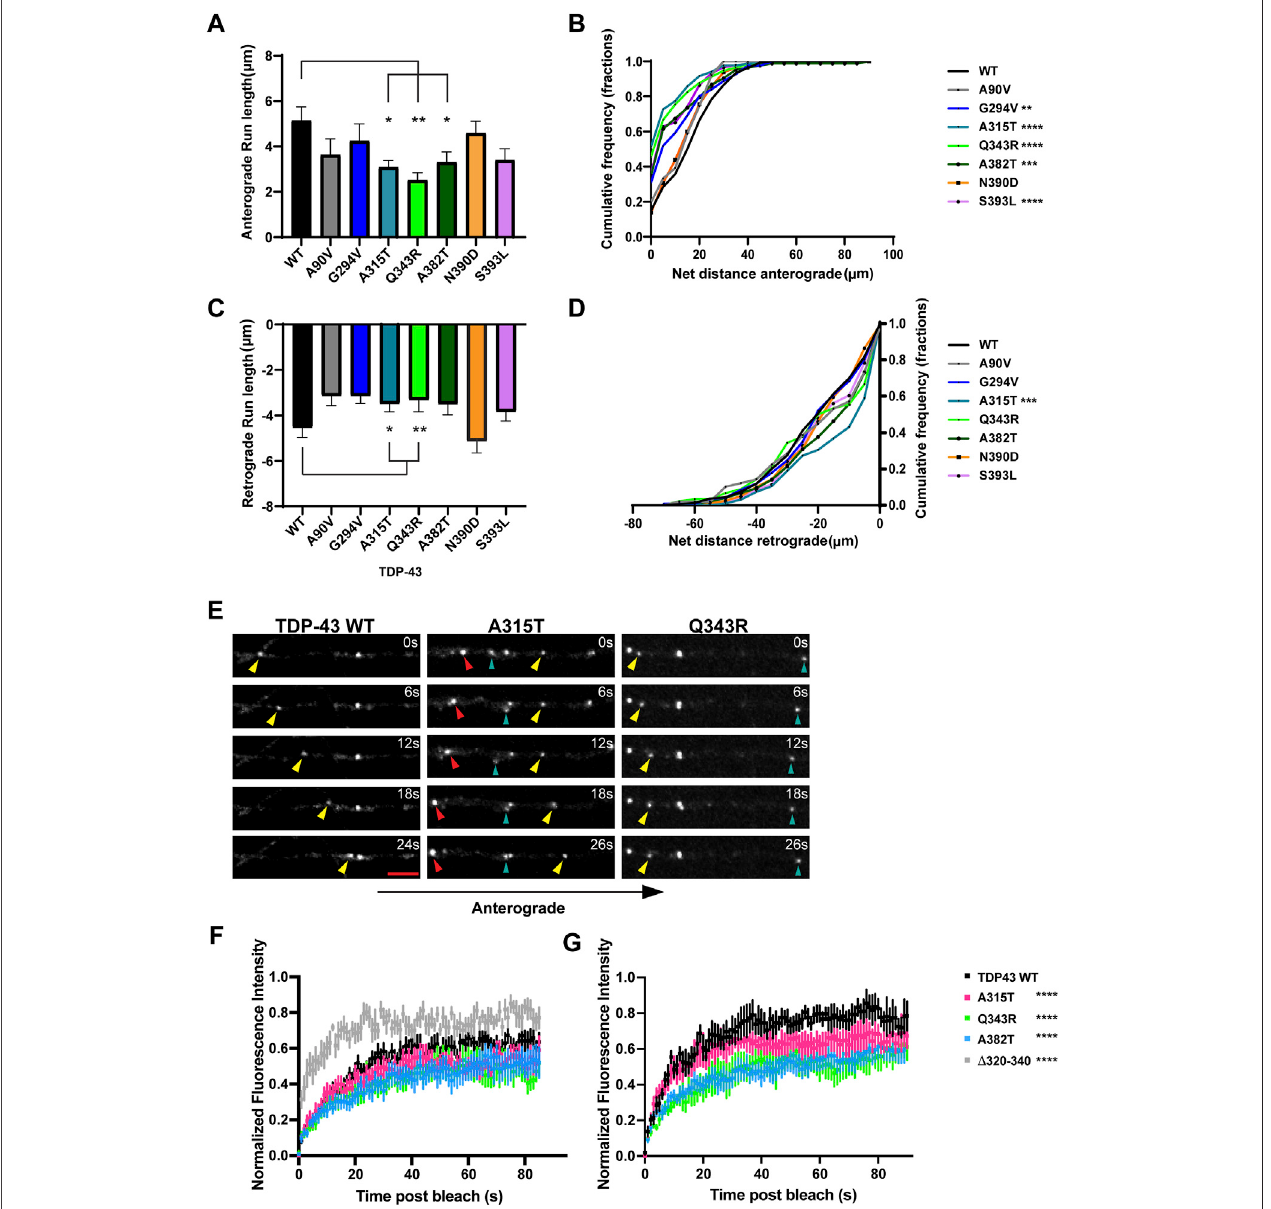
FIGURE 3 | ALS-linked TDP-43 mutants A315T and Q343R exhibit defects in anterograde and retrograde transport. (A) Anterograde run lengths ( μ m) of WT or ALS-linked mutant TDP-43 RNP granules were determined using custom semi-automated analysis in MATLAB. Run lengths (mean ± SEM) are plotted (WT n = 63, G294V n = 54, A315T n = 85, Q343R n = 45, A382T n = 75, N390D n = 59, S393L, n = 64, and A90V n = 19, from 12 to 16 neurons for each condition, N = 3). (B) CumulativefrequencydistributionofWTandALS-linkedTDP-43RNPanterogradenetdistancesfrom3independentexperiments. (C) Retrograderunlengths( μ m) ofWTorALS-linkedmutantTDP-43RNPgranulesweredeterminedusingcustomsemi-automatedanalysisinMATLAB;mean±SEMisplotted(WT n =100,G294V n = 77, A315T n =125and Q343R n = 65, A382T n = 85, N390D n = 45, S393L, n = 73, and A90V n = 26, from 12 to 16 neurons for each condition, N = 3). (D) Cumulative frequency distribution ofWT and ALS-linked TDP-43RNP retrograde netdistancesfrom 3 independent experiments. One wayANOVA(Kruskal – Wallis test with Dunn ’ s correction for multiple comparisons) was used to determine statistically signi fi cant difference among different samples, * p < 0.05, ** p < 0.01, *** p < 0.0005 and **** p < 0.0001. (E) Time-lapseimagesofrepresentativemotileTDP-43WTRNPgranule(leftpanel,yellowarrowhead)travellingintheanterogradedirection.Time-lapseimages of representative ALS-linked TDP-43 mutants, A315T (middle panel) and Q343R (right panel), showing the most severe transport defects. A315T and Q343R RNP granulesdisplayreducedanterograde(yellowarrowhead)and/orretrograde(redarrowhead)runs.OscillatoryRNPgranulesareshownwithcyanarrowheads;scalebar: 3 μ m. (F) ALS-mutant RNP granules (A315T, n = 12; Q343R n = 8; A382T, n = 10 from N = 3 independent experiments) in the axon display reduced fl uorescence recovery after whole bleach compared to TDP-43 WT RNP granules ( n = 10); 2-way ANOVA with Tukey ’ s post-test for multiple comparisons, **** p < 0.0001. TDP-43 Δ 320-330 RNP granules ( n = 8) show more robust and rapid whole bleach recovery than WT (2-way ANOVA with Tukey ’ s post-test for multiple comparisons, **** p < 0.0001). (G) Fluorescencerecoveryafterhalf-bleachofmidaxonalTDP-43WTgranules( n =9)orALS-linkedmutants[A315T( n =9);Q343R( n =5);A382T(n=10)]from ( Continued )